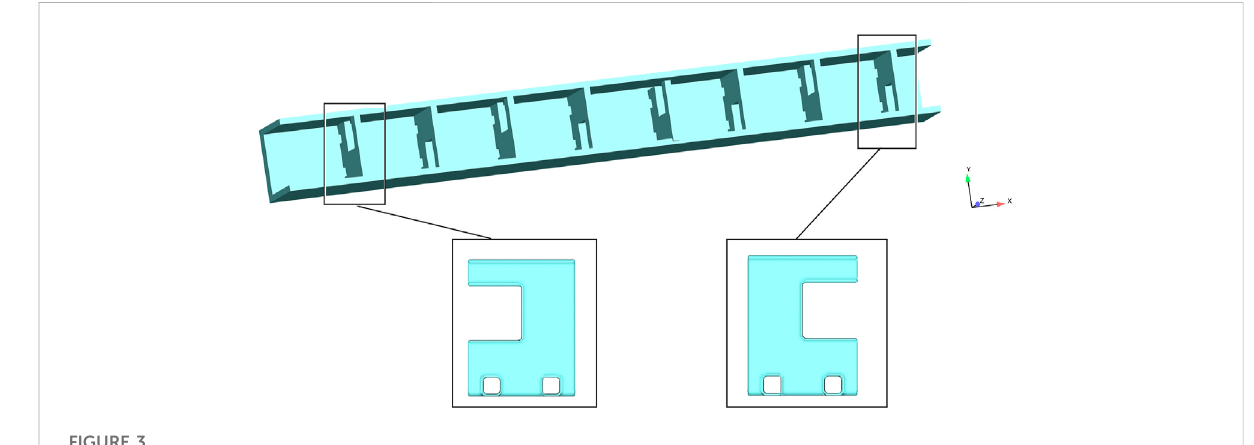
FIGURE 3 Schematic diagram of 3D model of ori fi ce fi shway.